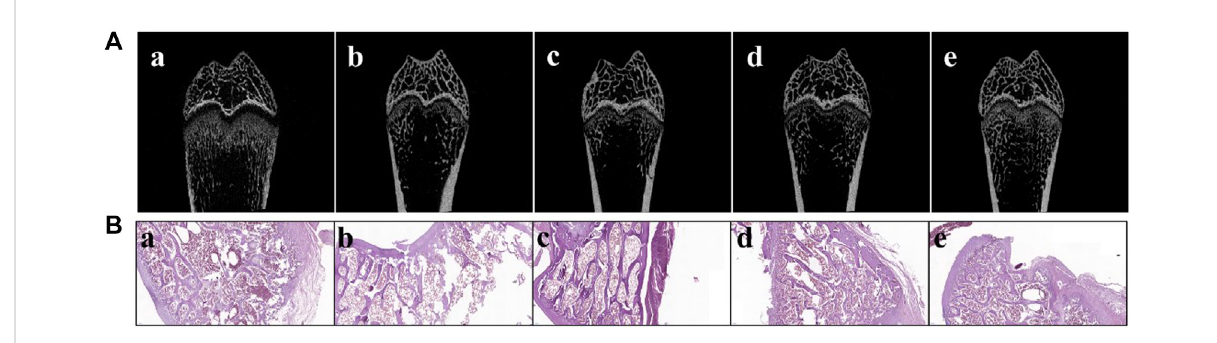
FIGURE 6 Micro-computed tomography scan (A) and histopathological photomicrographs (B) of femurs from ovariectomized (OVX) rats. (a. SHAM, b. OVX, c. OVX + ES, d. OVX + AS group, and e. OVX + AS-loaded TC ‒ mPEG ‒ PLGA micelles groups). The ES, AS, and AS-loaded TC ‒ mPEG ‒ PLGA micelles were administered at a dose of 0.5 mg/kg/2 days via the tail vein. OVX, ovariectomized; AS, astragaloside IV; ES, estradiol; TC,